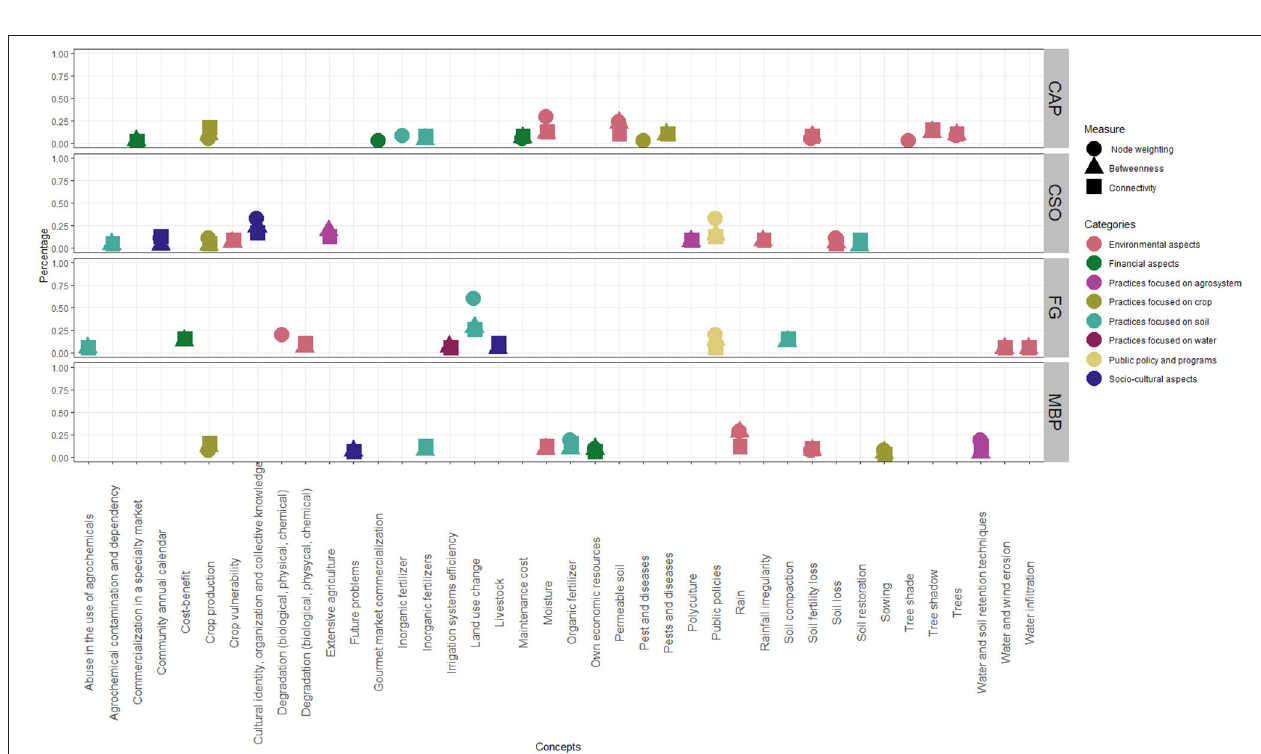
FIGURE 12 | Distribution of nodes centrality (connectivity and betweenness) and nodes weighting for each of the CMs.